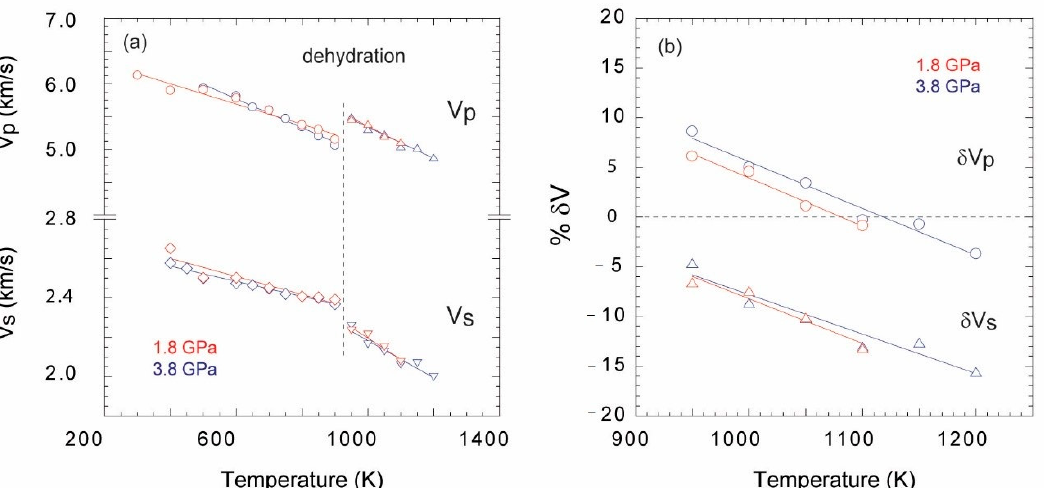
Figure 3. Scanning electron microscope backscattered electron images showing the chlorite sample after dehydration at ( a ) 1.8 GPa and ( b ) 3.8 GPa.